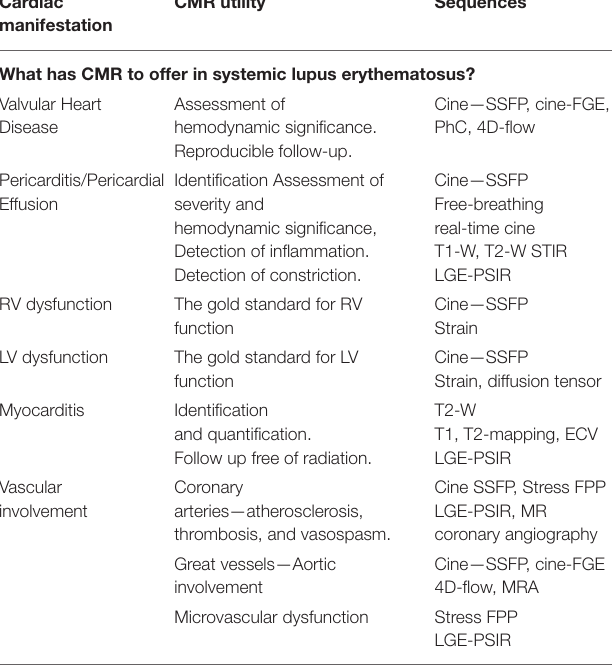
TABLE 2 | CMR offerings to the SLE. Cardiac